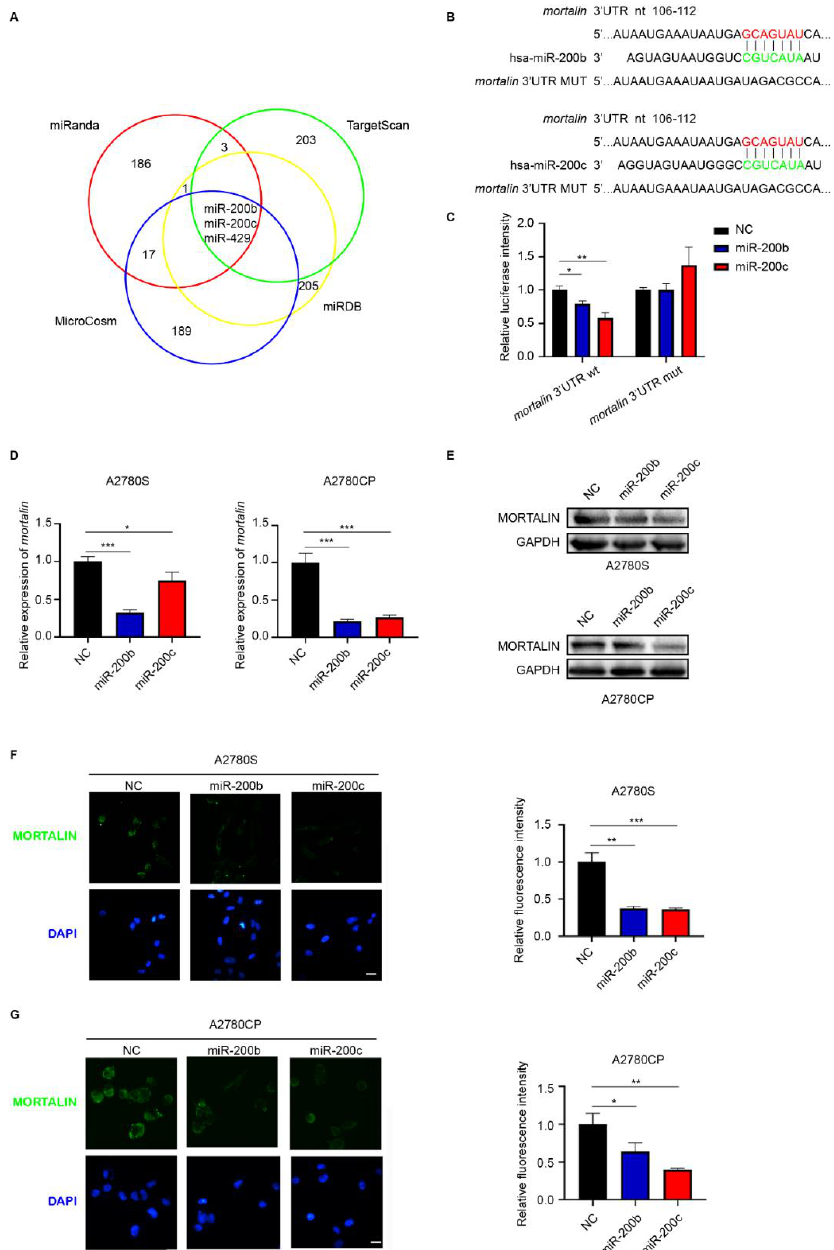
Figure 1. Mortalin is a direct target of microRNA (miR)-200b/c. ( A ) Venn chart depicts the intersection of the miRNAs predicted to regulate mortalin expression by four different miRNA databases; four circles represent the four different databases: TargetScan (green), miRanda (red), miRDB (yellow), and MicroCosm (blue). ( B ) The potential binding site of miR-200b/c on the 3 (cid:48) -UTR region of mortalin coding sequence and mutated sequence of the binding site. ( C ) Luciferase reporter gene assay detected the relative fluorescence intensity of firefly luciferin in 293T cells after co-transfection of miR-200b/c mimic or negative control sequence (NC) with pmiRGLO mortalin 3 (cid:48) -UTR or